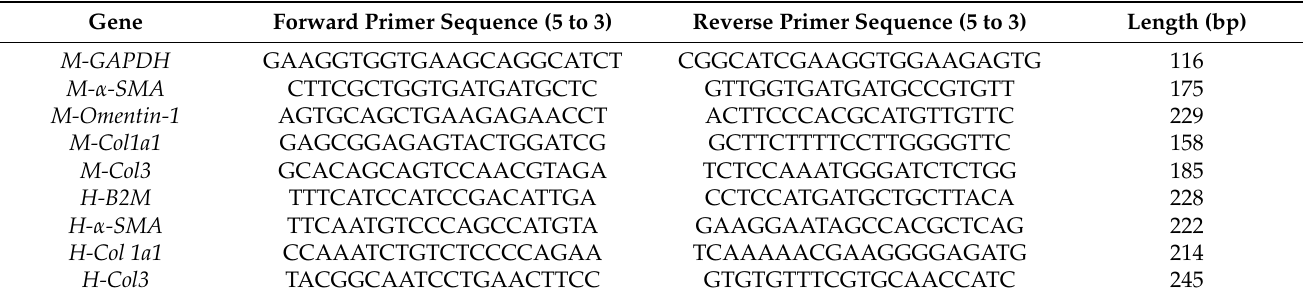
Table 1. Sequences of specific primers (mouse and human) used in this